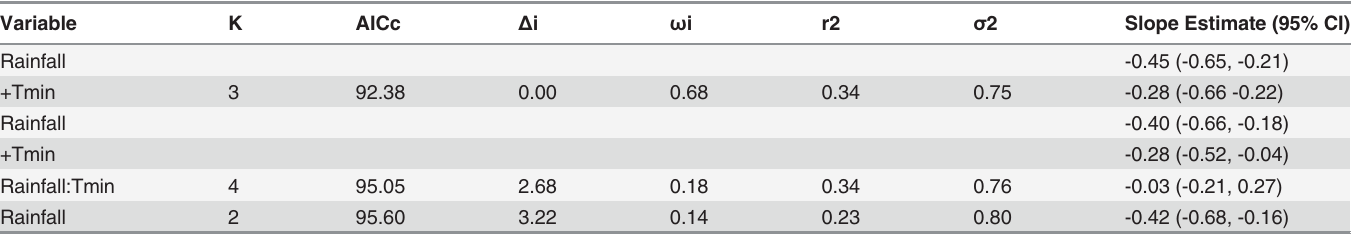
ω 2 = regression i ) = AIC weight, r